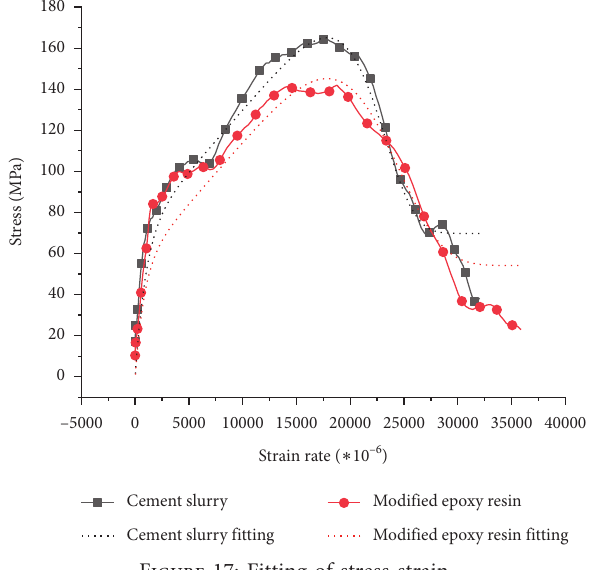
Figure 17: Fitting of stress-strain.